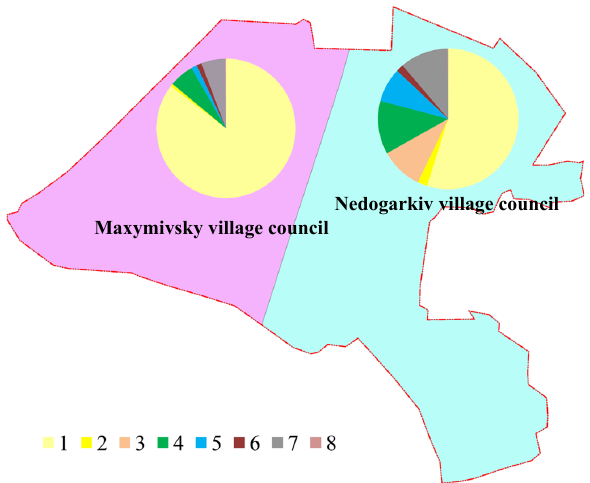
Fig. 2. Structure of the land fund within the former territories Maximivsky and Nedogarkiv village